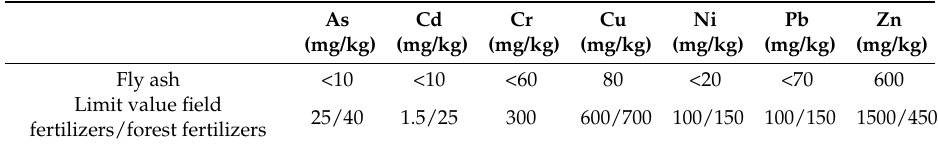
Table 2. XRF characterization of harmful element contents and a comparison to the limit values of Finnish fertilizer decree